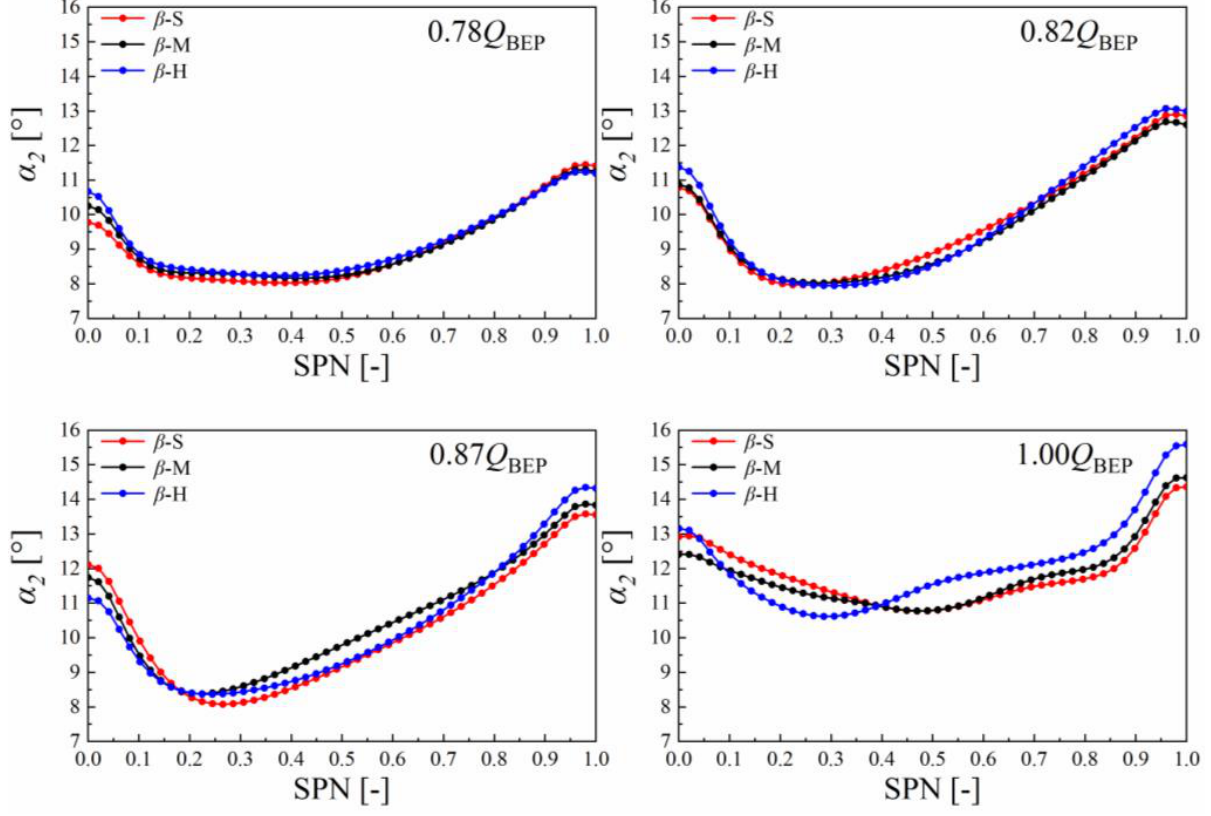
Figure 11. Distributions of the absolute flow angle α2 in the spanwise direction at the runner outlet at typical discharge operation points.